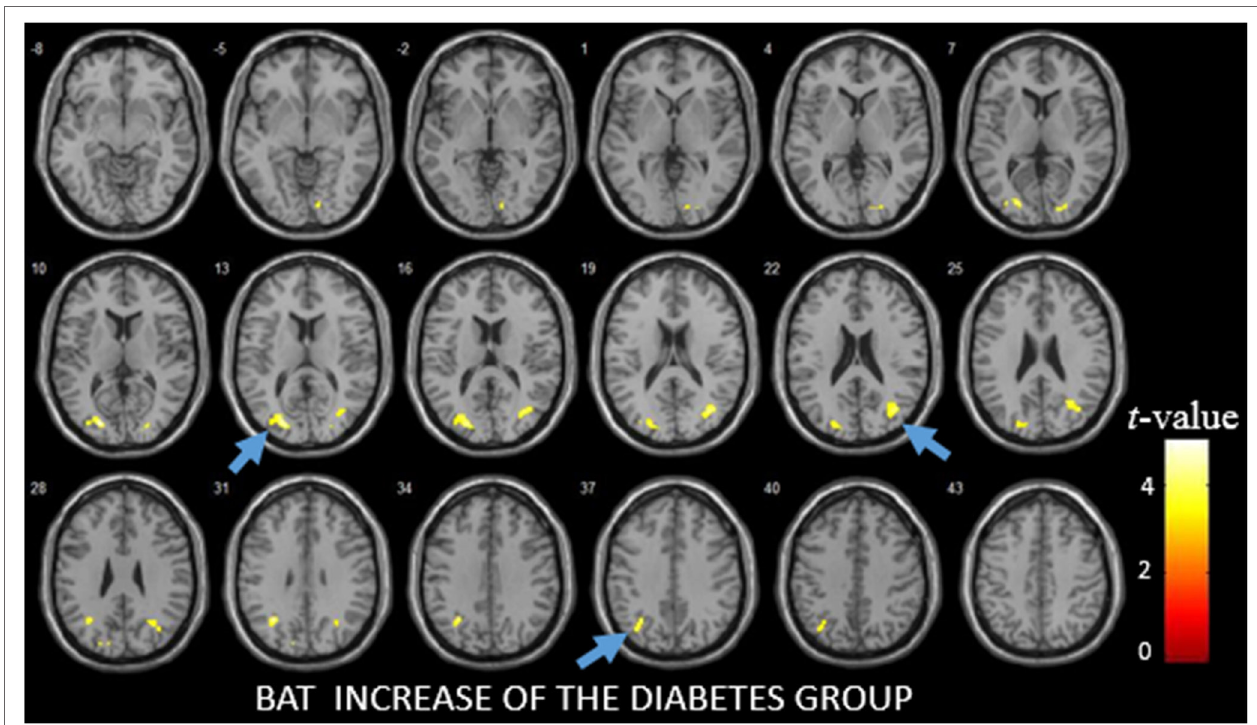
FigUre 2 | The difference of bolus arrival time (BAT) between patients with diabetes and the control group as detected by voxel-based analysis. The light blue arrows show three areas with the most significant differences in the BAT maps.